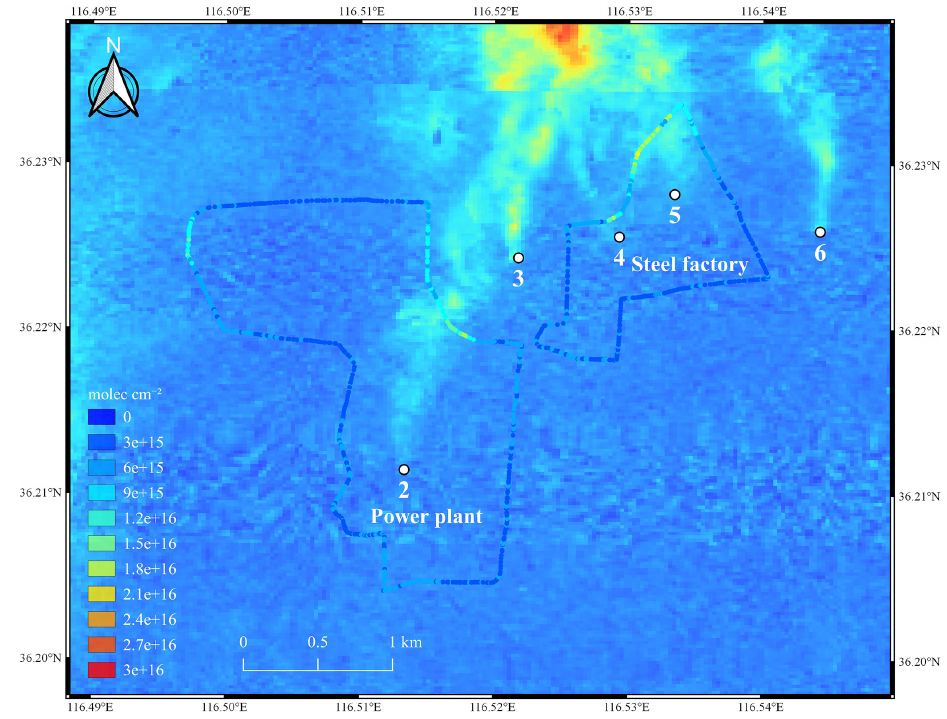
Figure 13. Overview of VCDs retrieved from the ground-based mobile DOAS system (circle marks) and VCDs retrieved by UVHIS (back- ground layer) measured on 23 June